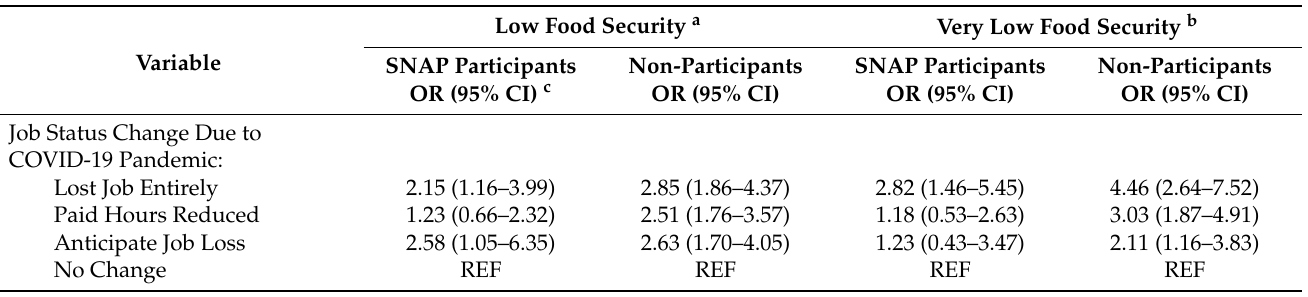
Table 4. Stratified Regression Models Examining Associations between Employment Status Change during Pandemic and Food Security